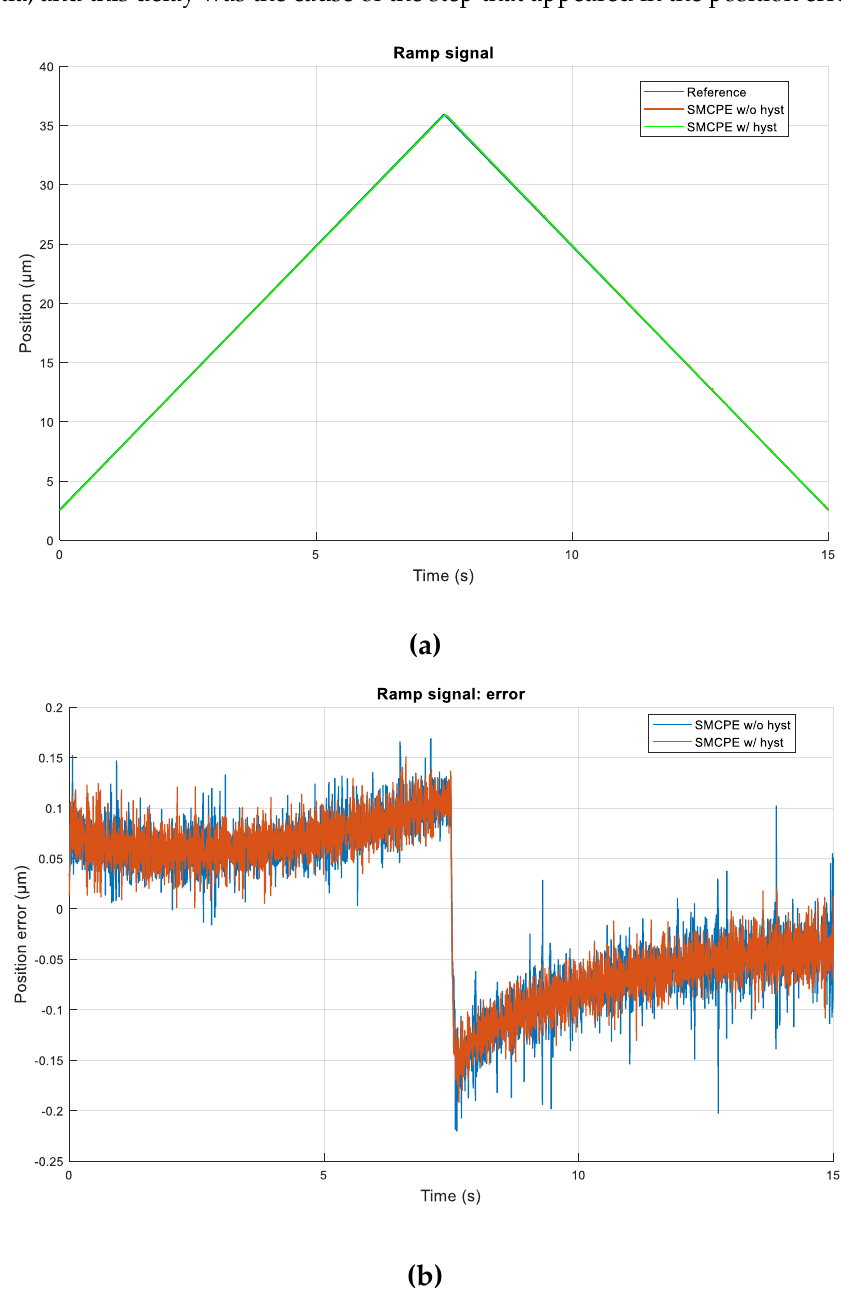
Figure 4. Effect of hysteresis feedback in sliding mode control with estimation perturbation (SMCPE) controller: ( a ) Position, and ( b ) Position error.